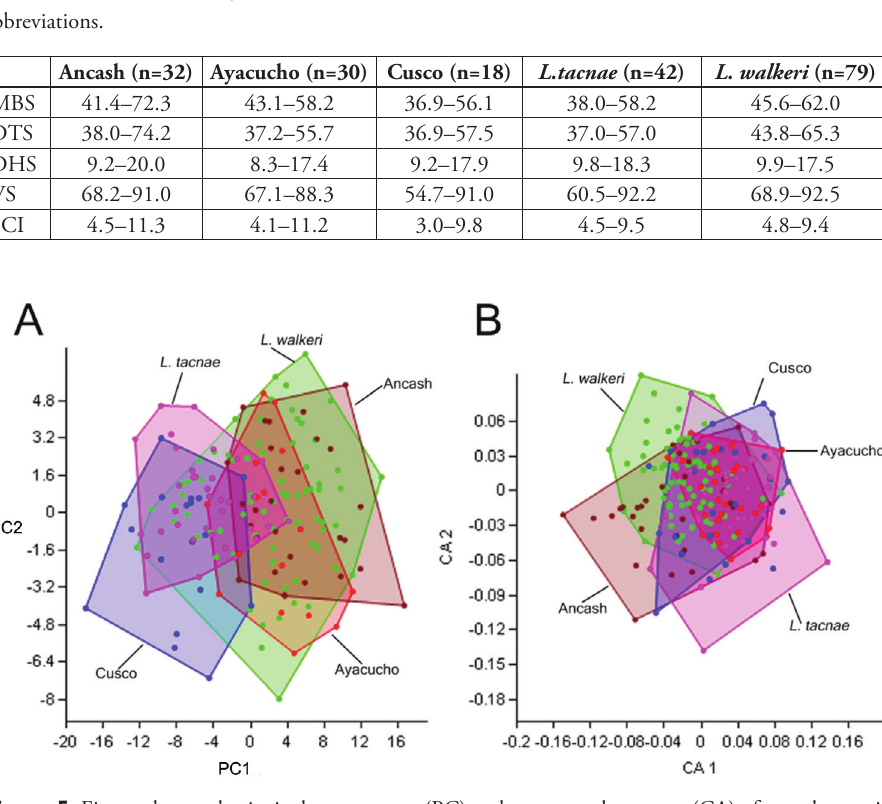
Figure 5. First and second principal components (PC) and correspondence axes (CA) of morphometric ( a ) and meristic ( B ) data of Ancash, Ayacucho, Cusco, L. tacnae and L. walkeri